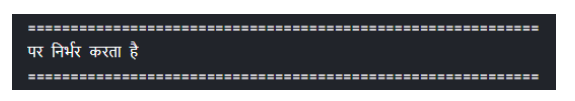
Fig 5.2 Output of Bigram model